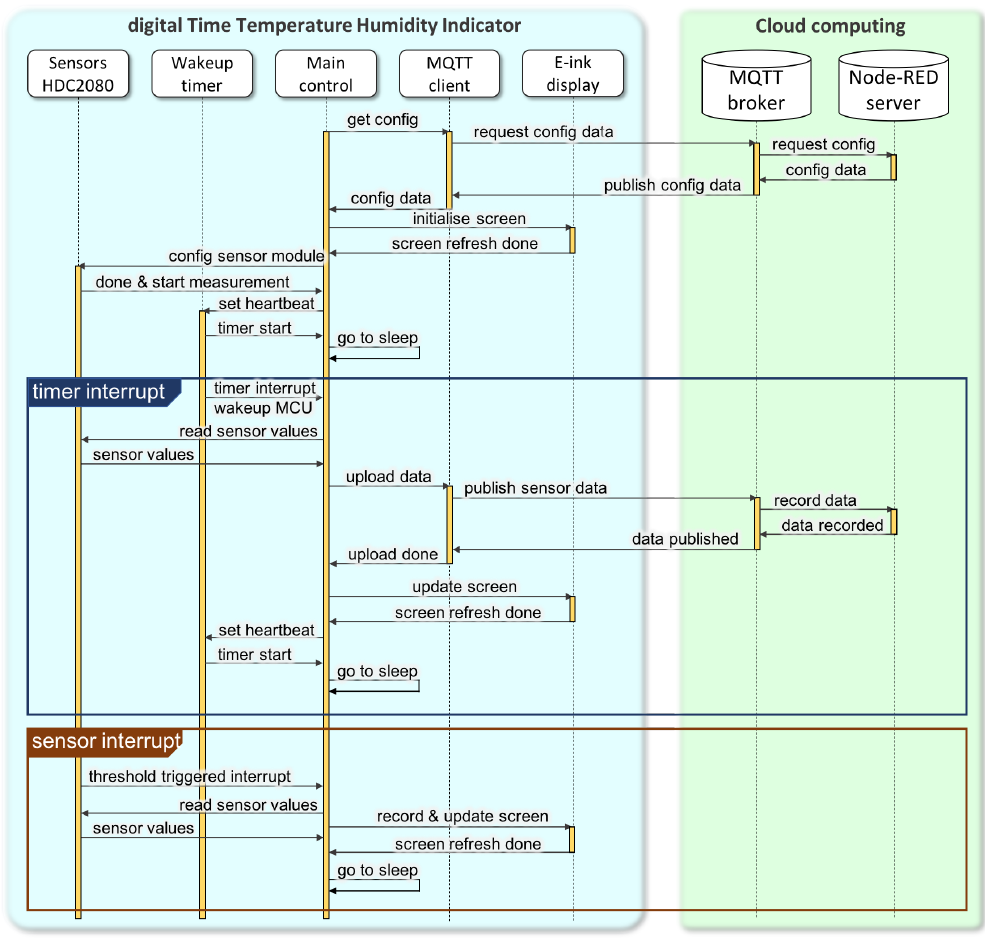
Figure 4. Sequence diagram of a dTTHI for medicine reuse based on the IoPT